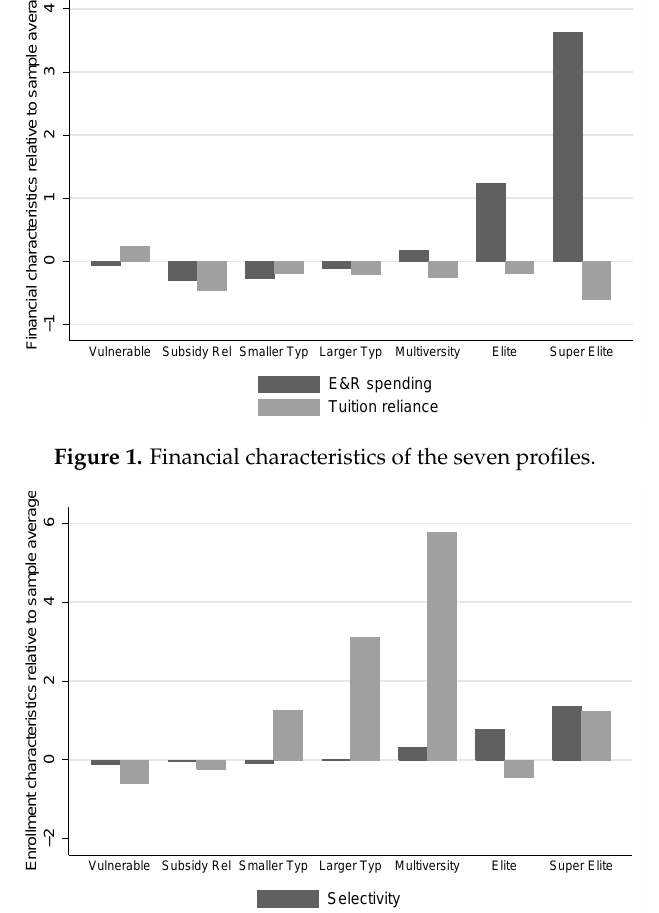
Figure 2. Enrollment characteristics of the seven